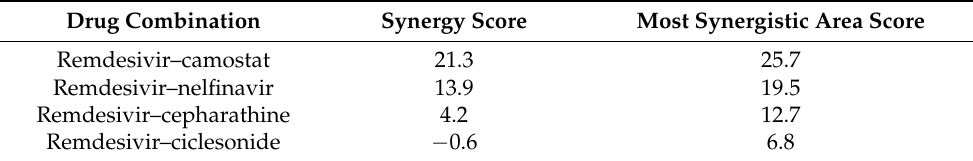
Table 1. ZIP synergy scores of drug combinations in SARS-CoV-2 infected Vero-E6 cells. Drug Combination Synergy